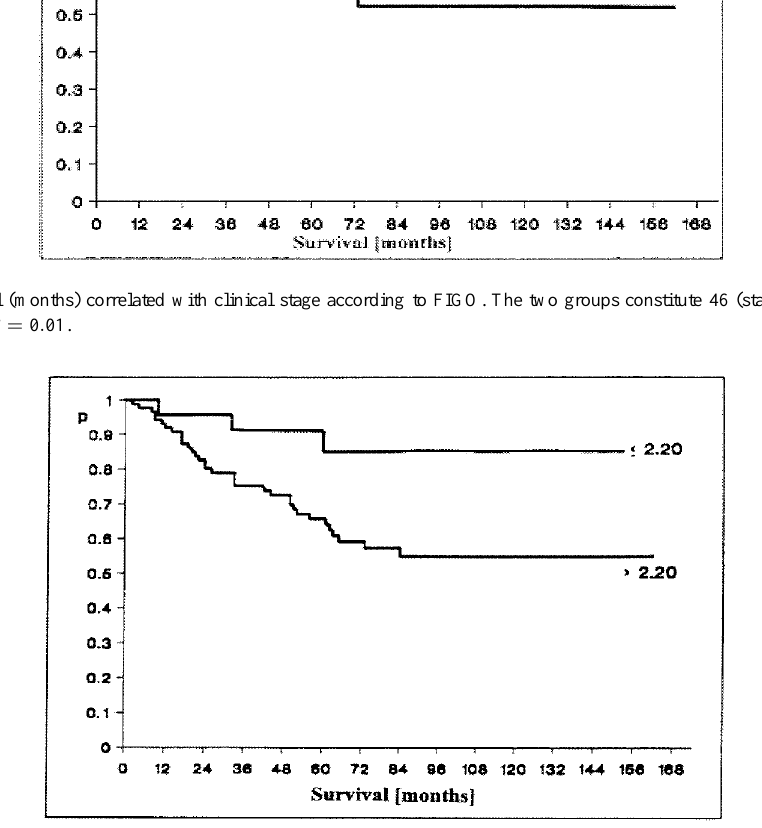
Fig. 2. Survival in months according to DNA ploidy using 2.2c as a cut-off value ( P < 0 . 05). The two groups constitute 24 ( (cid:1) 2.2c) and 88 ( > 2.2c) patients,